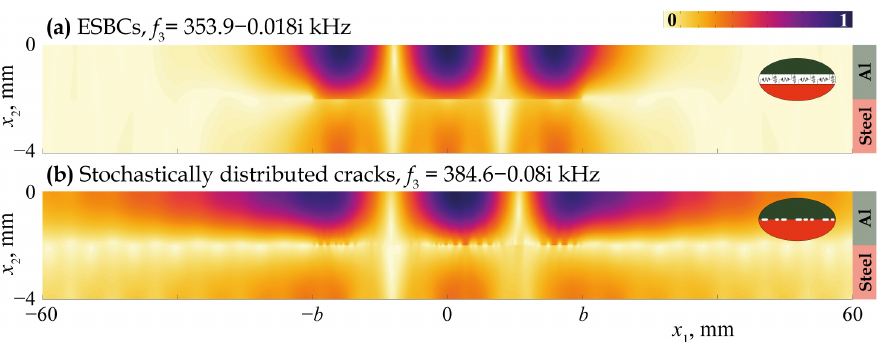
Figure 15. Eigenforms | u | ( x 1 , x 2 ) related to eigenfrequencies f 3 for a uniform partially closed delami- nation of length w = 40 mm with the crack density C = 0.8 modelled as an array stochastically ( b ) and via the ESBCs ( a